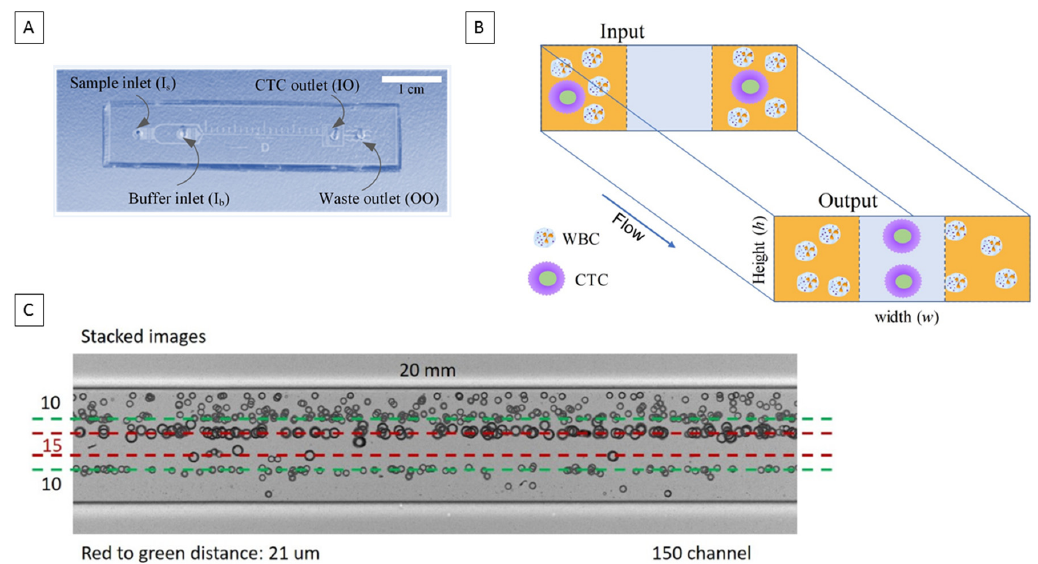
Figure 1. ( A ) Image of the straight microfluidic chip with descriptors for inlets; Sample Inlet (I s ), Buffer Inlet (I b )/outlets; circulating tumour cells (CTC) outlet (IO) and waste outlet (OO). Scale bar represents 1 cm. ( B ) A schematic representing how CTCs (single CTCs and CTC clusters) are focused to the centre of the channel. ( C ) Stacked image showing the focussing of 10 and 15 µm beads through the straight chip. 150 channel represents the channel width in µm. WBC: White blood cells.